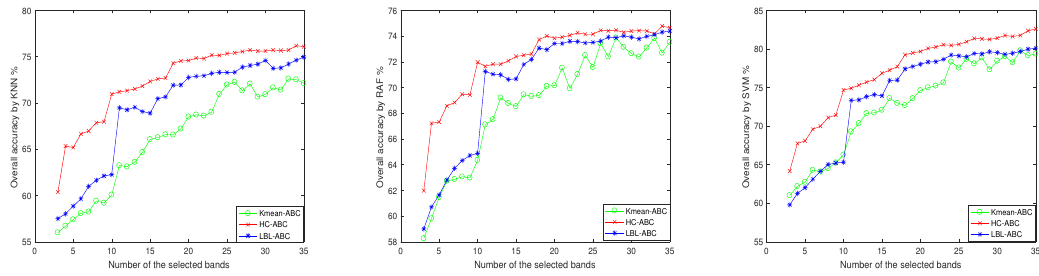
Figure 15. The OA values obtained by K-mean-ABC, HC-ABC, and LBL-ABC on Indian